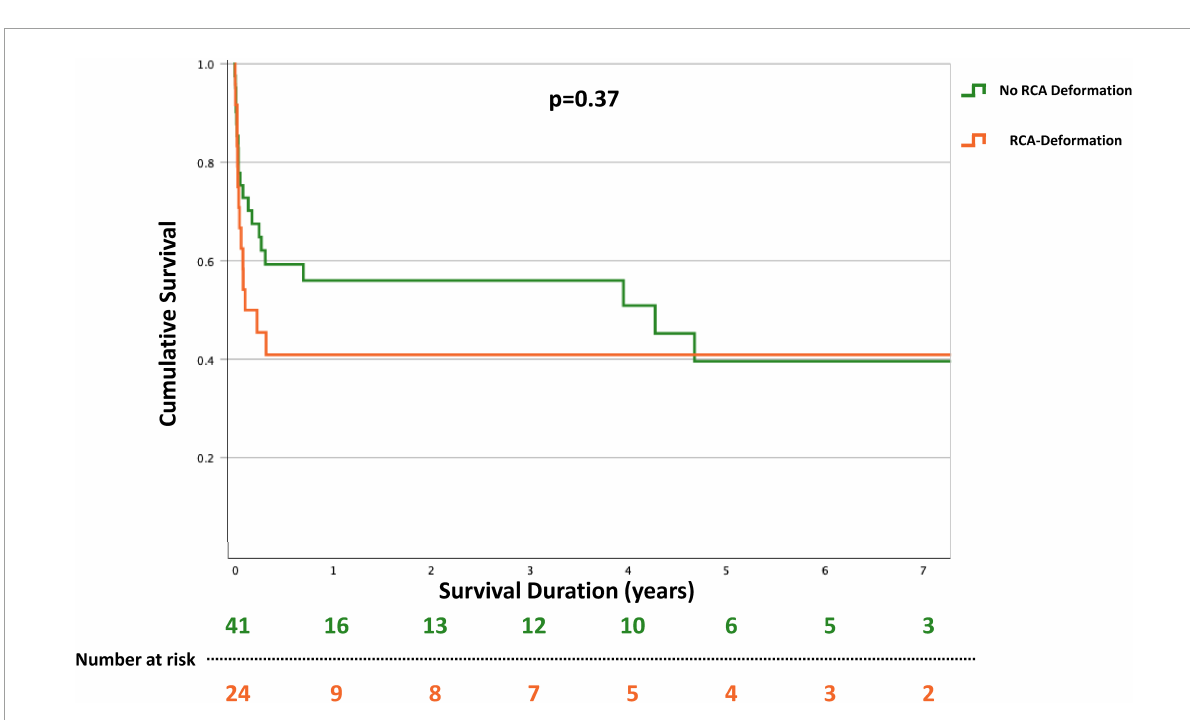
FIGURE4 Kaplan–Meyer curves for long-term all-cause mortality in patients with and without right coronary artery (RCA) deformation after tricuspid valve surgery for tricuspid regurgitation. The mortality rate did not differ between patients with and without RCA affections who immediately underwent coronary angiography after